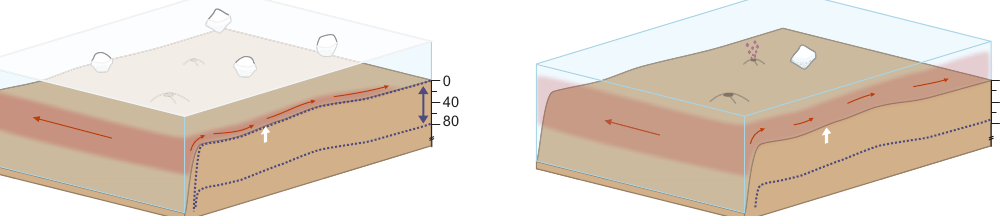
Fig. 5 Schematic paleoenvironmental evolution of the Pingo Area and the Svalbard-Barents Sea Ice Sheet (SBIS) since the Late Glacial. Gas hydrate stability zone (GHSZ) thickness changes in meters below sea fl oor (mbsf) in relation to bottom water temperatures and ice retreat patterns are shown from the Late Glacial to the Holocene ( A – F ). The dark purple dotted line indicates the base of the gas hydrate stability zone (BGHSZ), which corresponds to the lower limit of the GHSZ. The uppermost limit (top of gas hydrate occurrence zone) is at the sea fl oor 22 . In fl ow and relative temperature of the Atlantic water is shown in red, where stronger red indicates a relatively higher temperature. A thick white arrow marks the position of core 1059. Age for each interval is shown as calibrated ages before present (BP). Note that the water depth is not drawn to scale. See Fig. 4 for